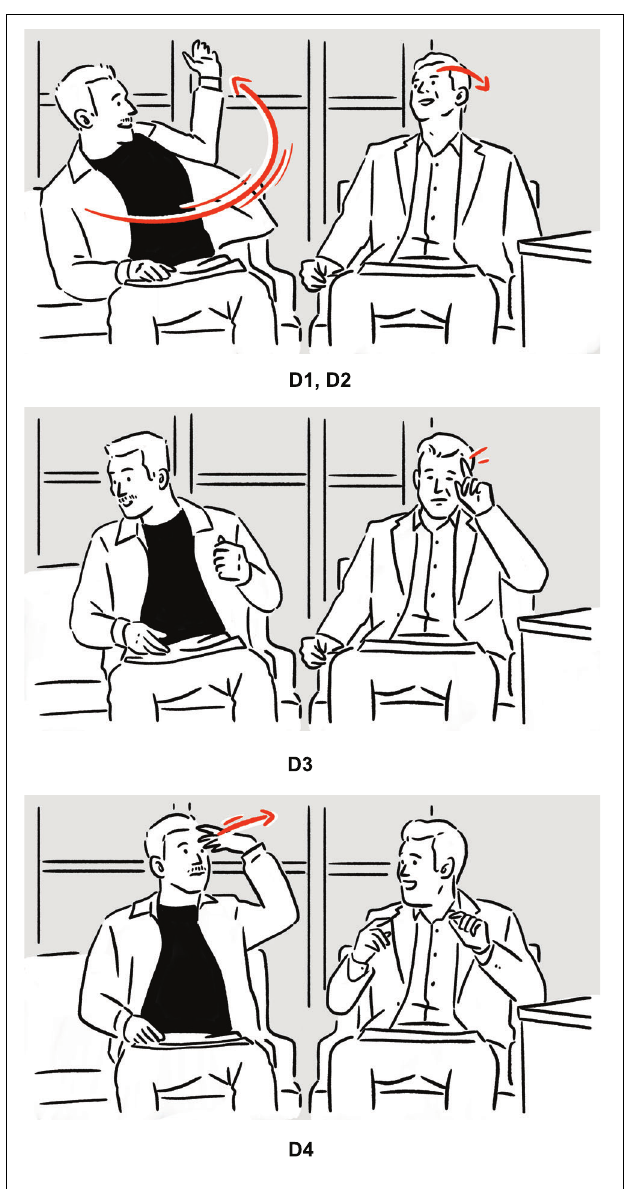
FIGURE 17 | Depictions in